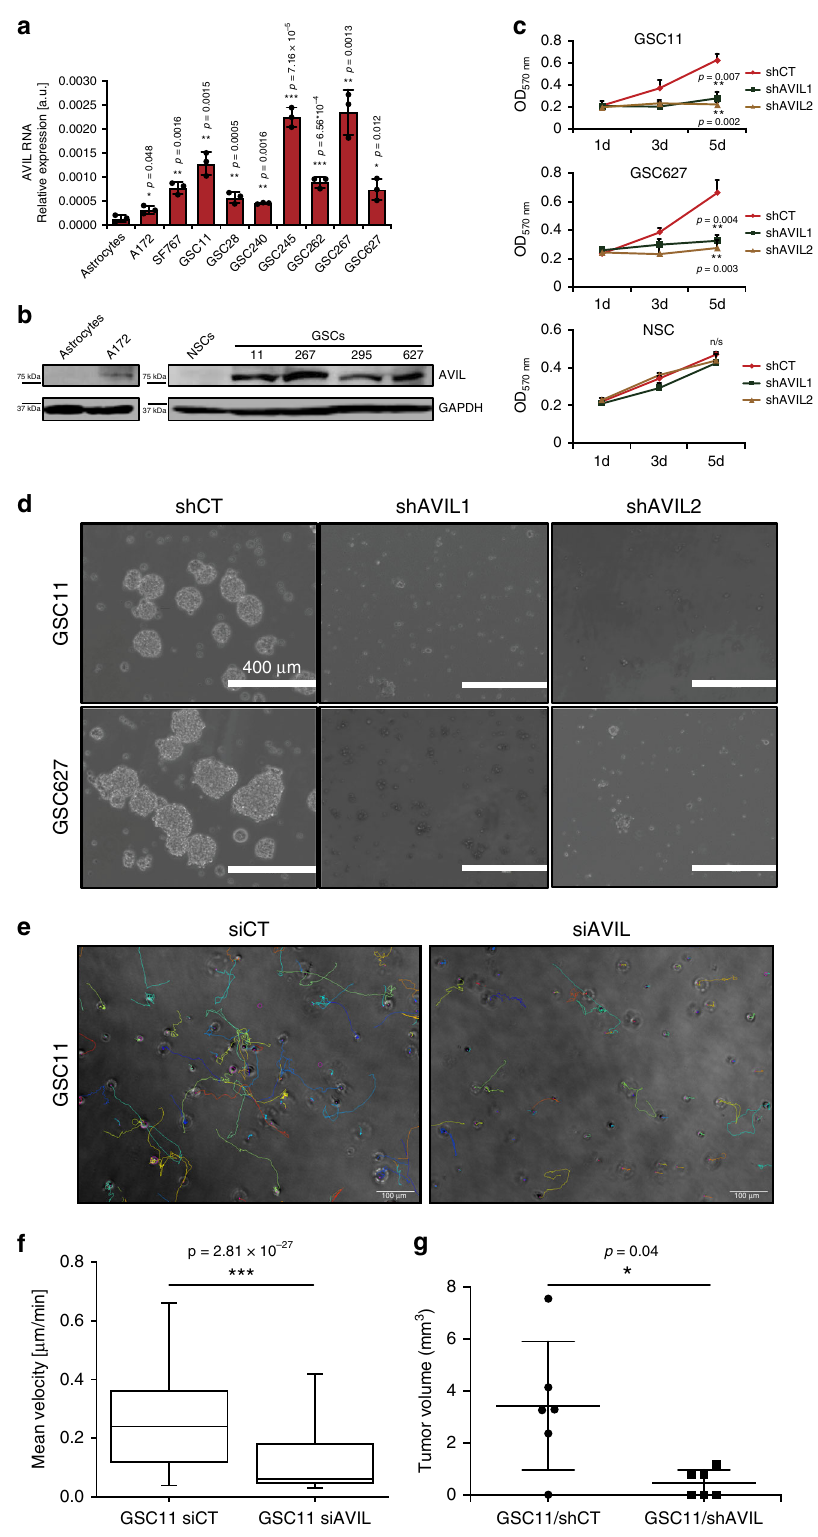
(Fig. 4d). Not surprisingly, the expression of stemness markers was reduced, whereas both astrocyte and oligodendrocyte differentiation markers were induced when AVIL was silenced (Supplementary Fig. 8). Using live-cell imaging, we traced the movement of GSC individual cells in 3D culture. Similar to